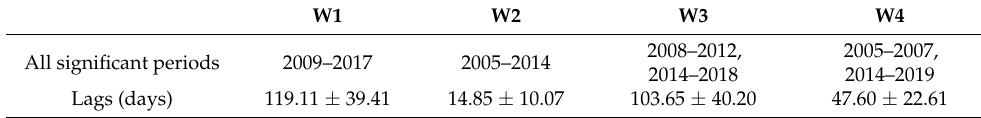
Table 6. Time lags from the cross wavelet spectra between HI and GWLs (period of 365 days band). W1 W2 W3 W4 All significant